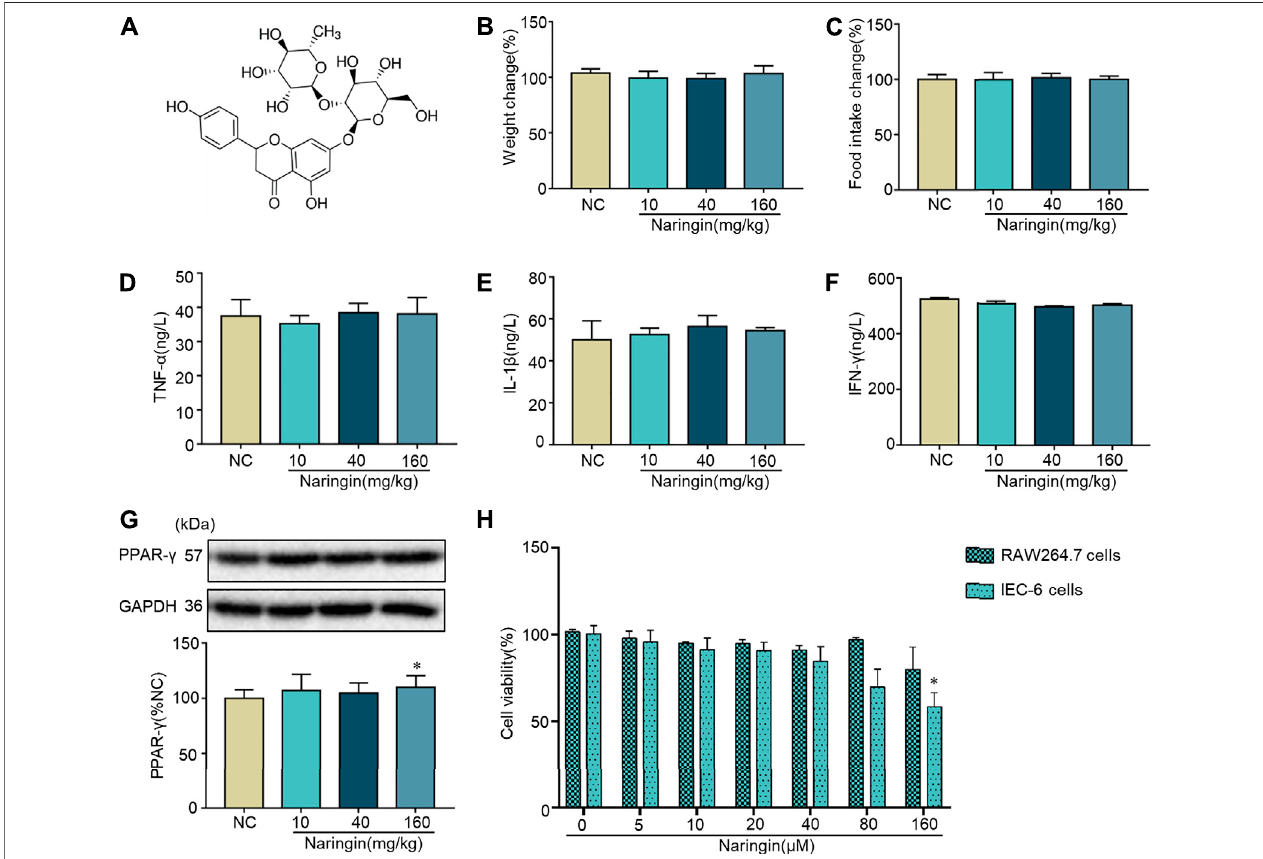
FIGURE 1 | Toxicity of naringin in normal cells and mice. (A) Chemical structure of naringin. Naringin was administered to mice by gavage once a day for seven consecutivedays.Effectsofnaringinon (B) bodyweightand (C) foodintake.Expressionlevelsofthecoloniccytokines (D) TNF- α , (E) IL-1 β ,and (F) INF- γ wereexamined by ELISA, and expression levels of (G) PPAR- γ were examined by western blotting. (H) Cytotoxicity of naringin was studied by CCK8 assay in RAW 264.7 and IEC-6 cells. Dataare expressed asthemean ± SD. Values inthenormalcontrol(NC) group areset to100%,and other valuesare givenrelativetotheNC group. * p < 0.05 compared with NC group. n (cid:2) 3 samples in western blotting experiments; n (cid:2) 6 samples for other experiments. These blots are cropped, and the full-length blots are presented is in the Supplementary Figure S1